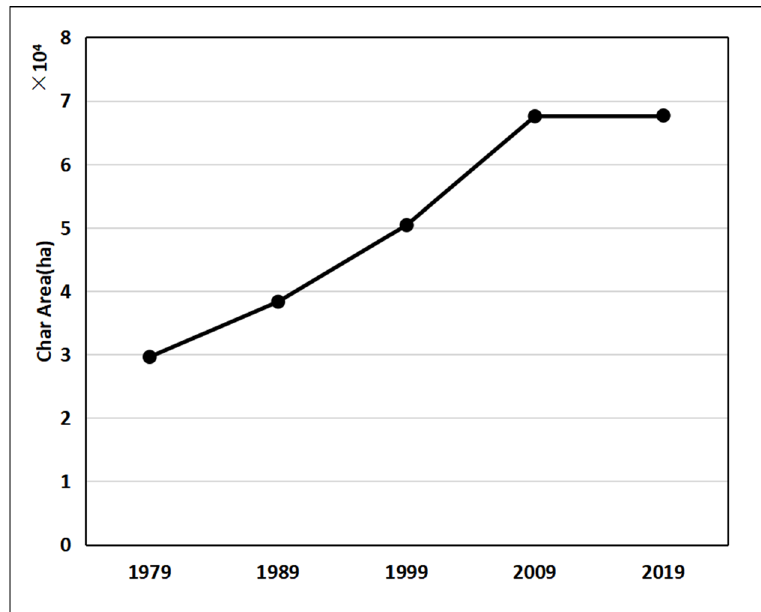
Figure 12. Char area change of the Padma River [40].